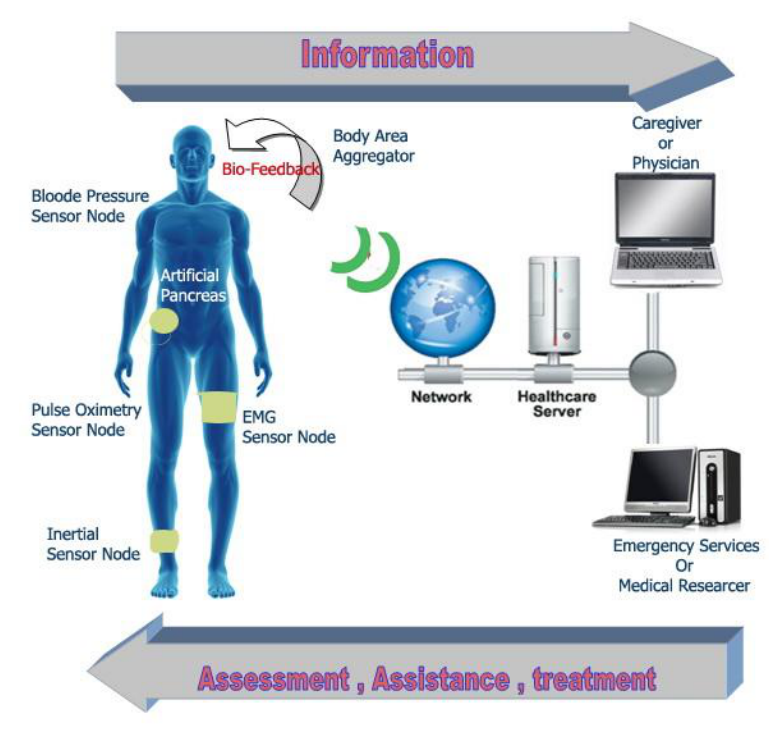
Figure 3. WBAN and its